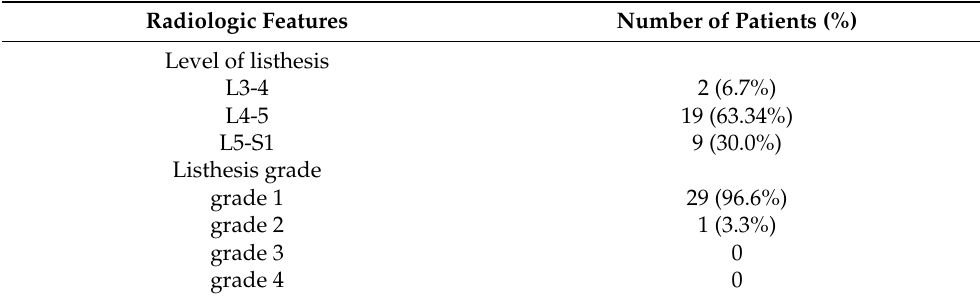
Table 2. Radiologic features spondylolisthesis